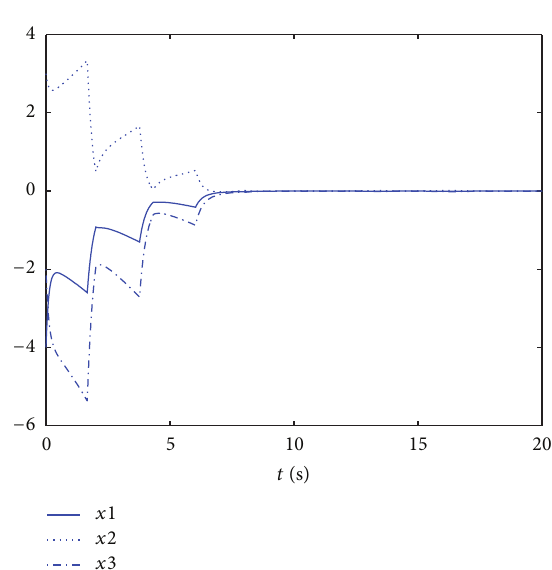
Figure 2: Switching surface 𝑠(𝑡) .